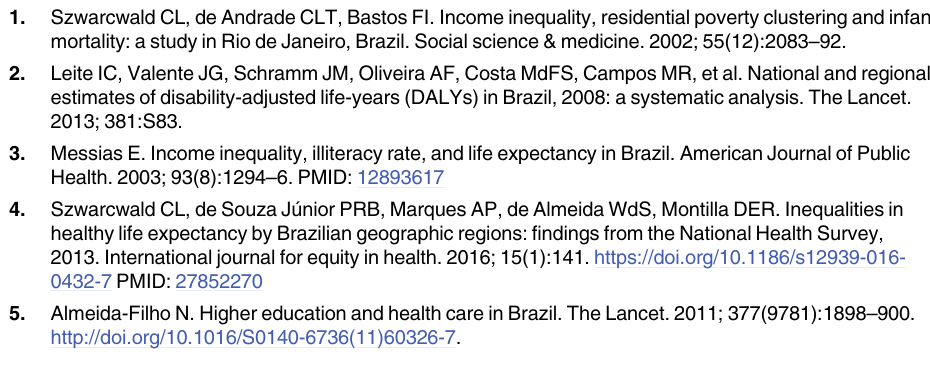
S3 Table. Comparison of results using full sample and restricted sample (with no proxy respondents) using logistic and LPM models. Models further adjusted for age, sex, race, region, health insurance, medical conditions, and proxy (models with full sample).